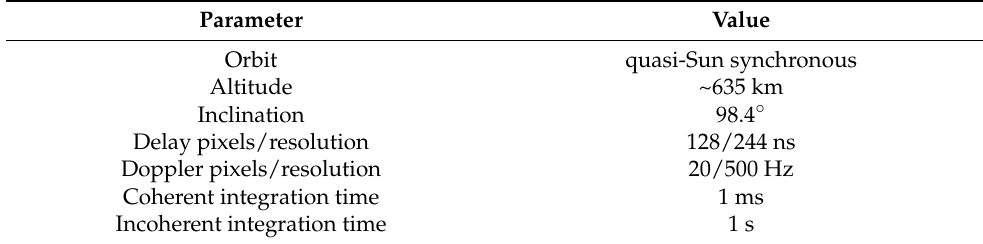
Table 2. Orbit and instrument specifications of TDS-1 [45].